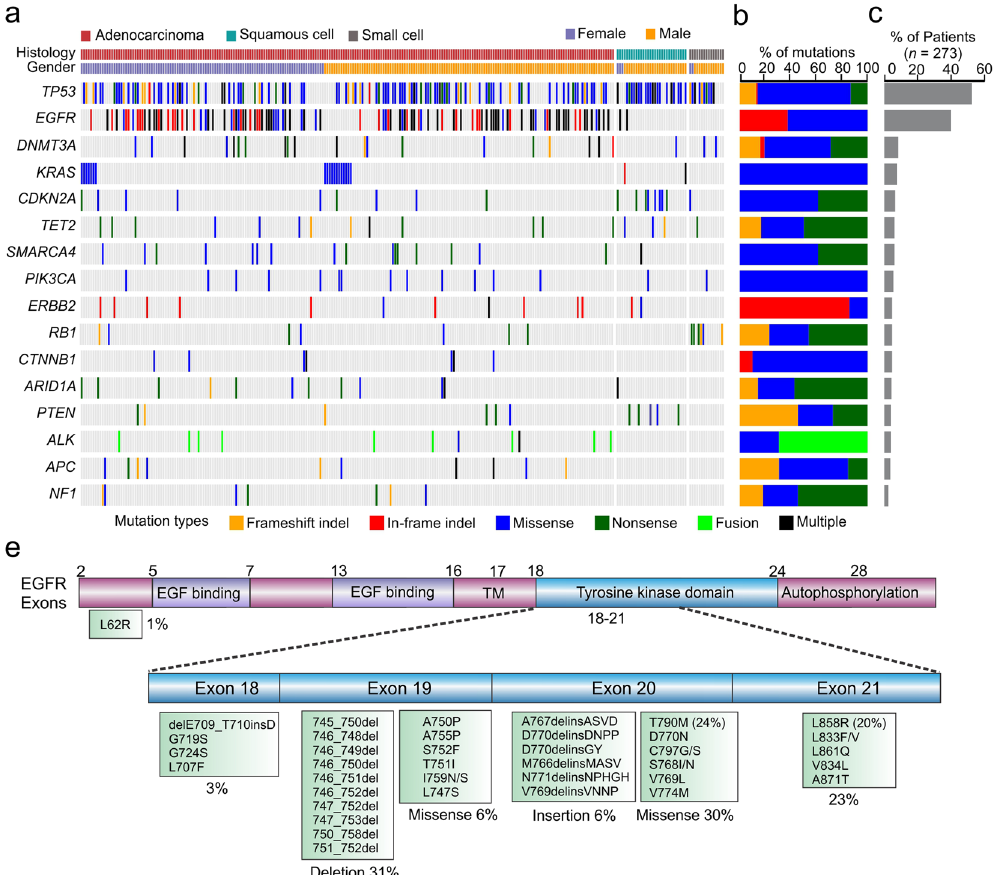
Figure 6. Mutation analysis of lung cancer patients. ( a ) A co-mutation plot of various types of mutations in the ctDNA of lung cancer patients. Only genes with more than 10 occurrences are shown in this plot. ( b ) The composition of mutation types within each gene. ( c ) The percentage of patients with mutations in each gene. ( d ) The specific mutations identified in EGFR and their frequencies in the ctDNA of our